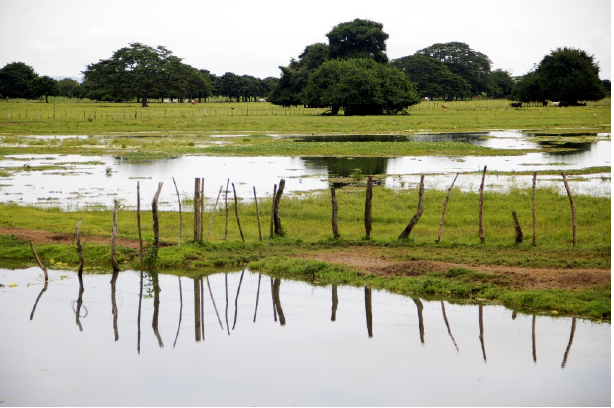
Figure 3. Distinctive picture of the Cordoba Landscape. Source: Massimo Leserri, 2017 [4].